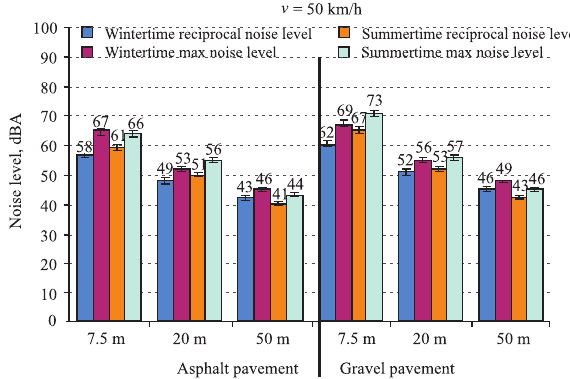
Fig. 4. Th e reciprocal and the max noise levels of a car driving in the wooded area